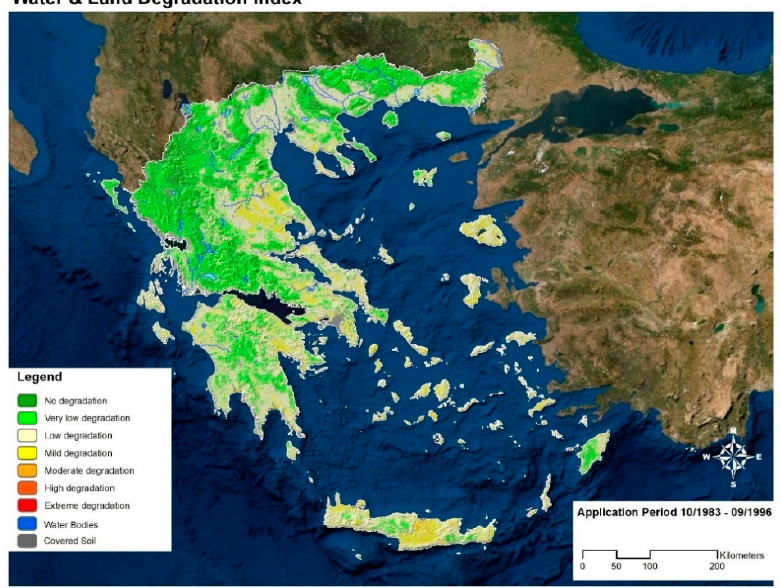
Figure 8. WLDI results for the period 10/1983-09/1996.